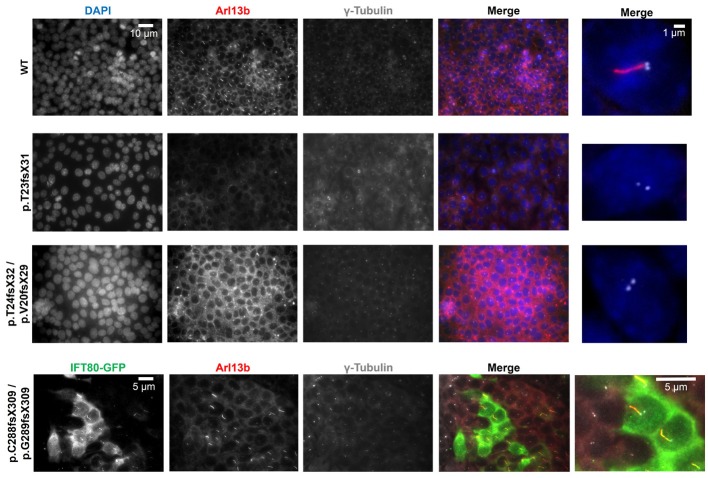
Analysis of ciliogenesis in multiple mutant cell clones.Lower power images show many cells in the field of view for three independent clones. Every cell lacks cilia but retains a single basal body. Far right image shows confocal images at higher magnification. For the p.C288fs/pG289fs mutant clone, transfection of IFT80-GFP is shown. Note that only GFP +cells produce cilia, showing a functional rescue.